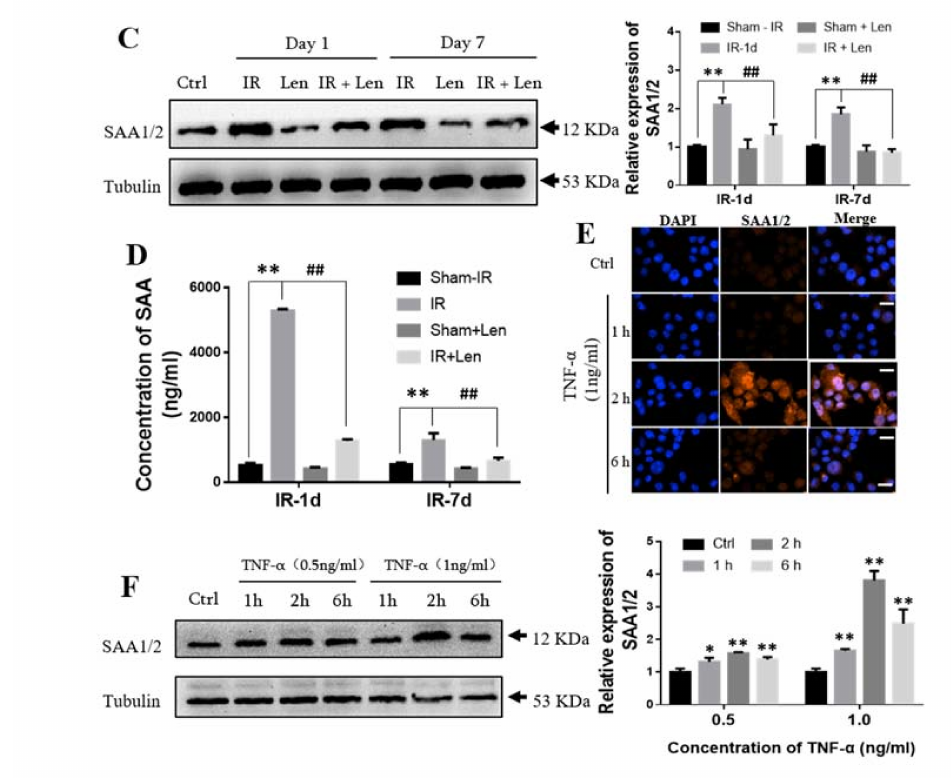
Figure 6. TNF- α induces the expression of SAA in vivo and in vitro. For in vivo experiments, mice were pretreated with or without TNF- α inhibitor lenalidomide (50 mg/kg/d, len) by in- traperitoneal injection before Th-IR (8 Gy × 3). The serum and liver were collected at different time points after Th-IR. For in vitro experiments, the expressions of SAA1/2 were observed in mouse hepatoma cells Hepa1–6 treated with TNF- α . ( A ) Immunohistochemical staining of TNF- α in lung tissue at day one after Th-IR. Bar = 100 µ m. ( B ) Immunohistochemical staining of SAA1/2 in lung and liver tissue section of mice with indicated treatment at day 1 after Th-IR. Bar = 25 µ m. ( C ) Western blot analysis of the expression of SAA1/2 protein in the liver of mice with indicated treatment. ( D ) The concentration of SAA in the serum of mice with indicated treatment. ** p < 0.01 indicated a significant difference with sham group, ## p < 0.01 indicated a significant difference with the IR group. ( E ) Immunofluorescence staining of SAA in Hepa1–6 cells after the treatment with TNF- α . Bar = 25 µ m. ( F ) Western blot analysis of the expression of SAA1/2 protein in Hepa1–6 cells after the treatment with TNF- α . * p < 0.05 and ** p < 0.01 compared with control group. n = 8–10 for mice experiments. All in vitro experiments were repeated at least three